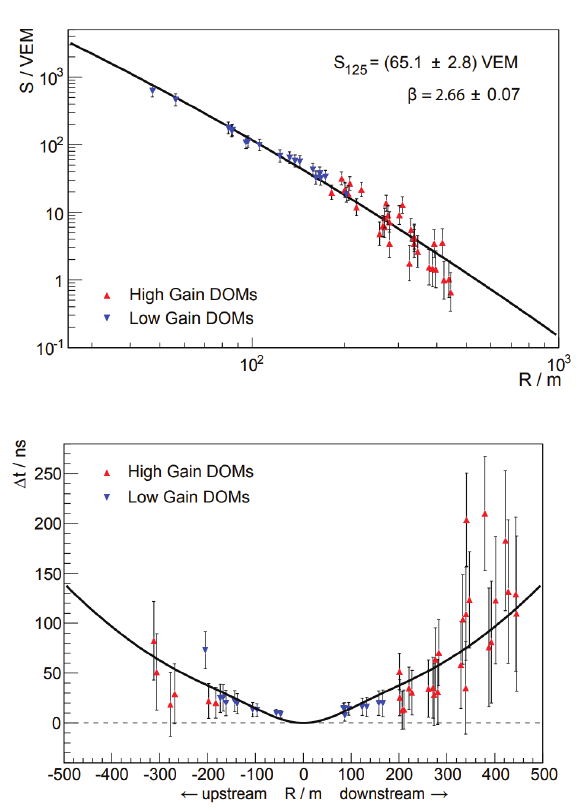
Figure 2: Example of the IceTop air shower reconstruction [3]. (Top) Lateral fit to signals from 25 triggered stations with a reconstructed shower size S 125 = (65 . 1 ± 2 . 8) VEM. (Bottom) Time residuals with respect to a plane perpen- dicular to the shower direction. “Upstream” and “down- stream” refer to tanks being hit before and after the shower core reaches the ground.